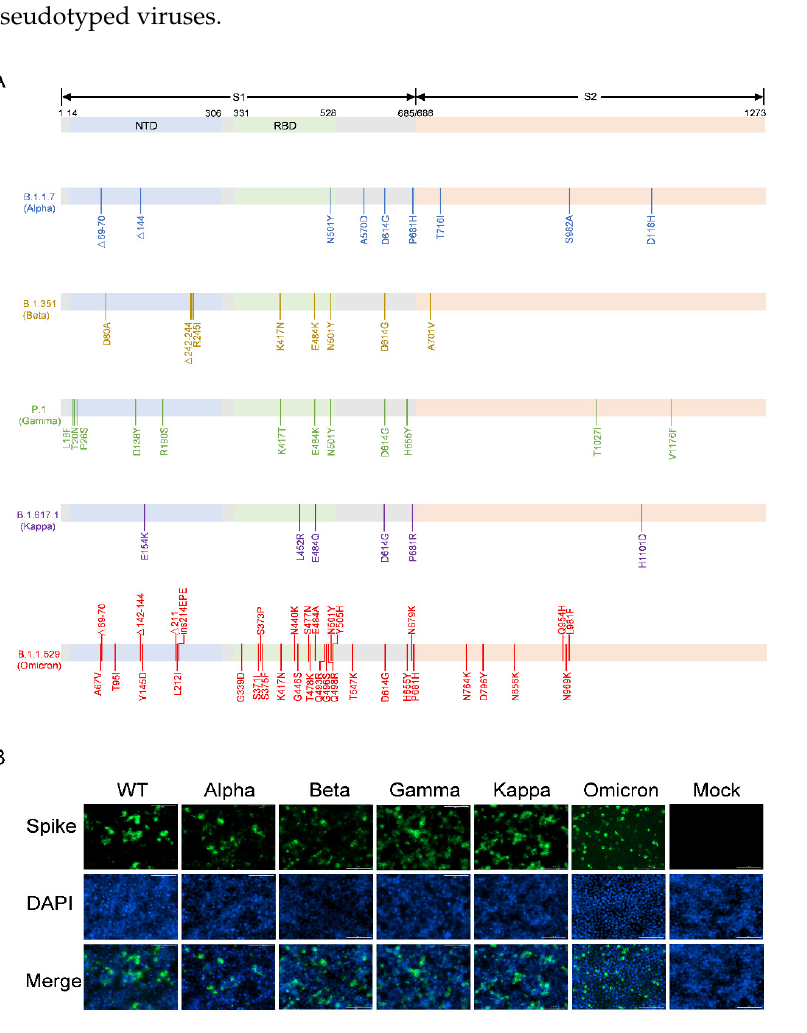
Figure 1. Detection of SARS-CoV-2 variants S protein expression in HEK293T cells. ( A ) Schematic overview of spike protein of SARS-CoV-2 variants, including Alpha (B.1.17), Beta (B.1.351), Gamma (P.1), Kappa (B.1.617.1), and Omicron (B.1.1.529). Amino acid mutations in comparison to the Wu-